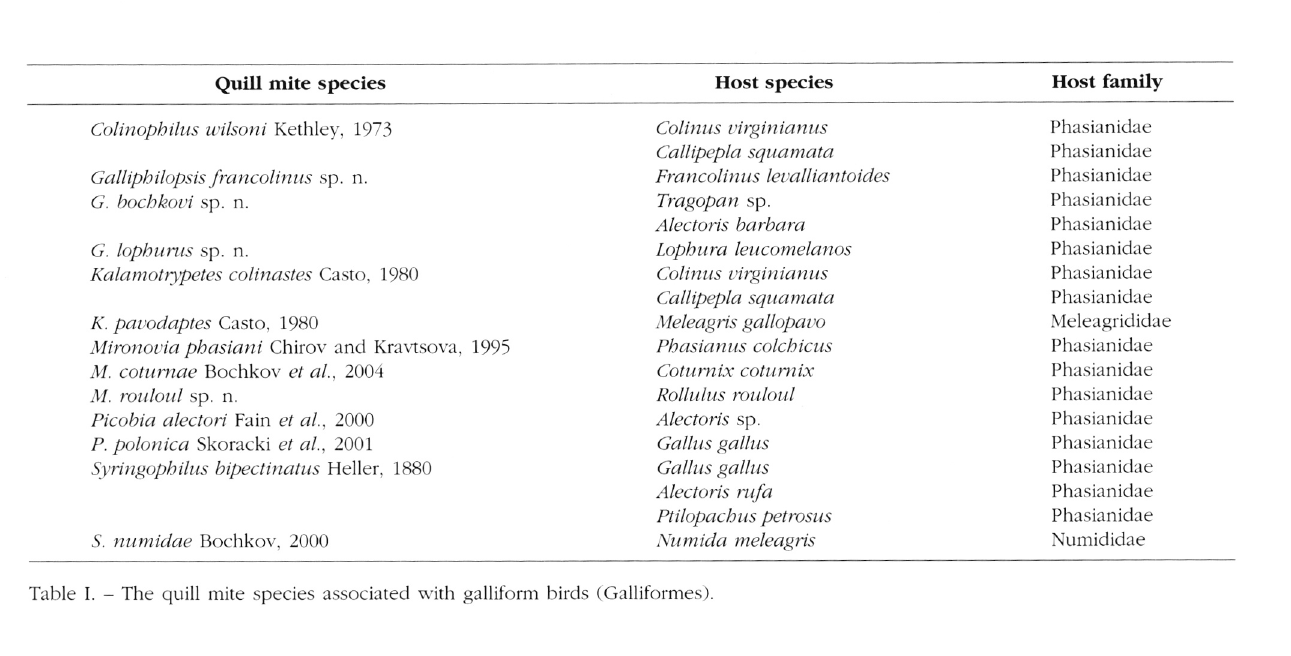
lactophenol medium and examined with the Nomarsky interference-contrast-phase with microscope Olympus BH2. The precise data on the localities for many inves­ tigated birds were unknown. The nomenclature of idiosomal setae follows Fain (1979) in the version adapted for the family Syringophilidae (Bochkov & Mironov, 1998) and the chaetotaxy for the legs is that of Grandjean (1944). Bird taxonomy follows that of Howard and Moore (1991). All measurements in des­